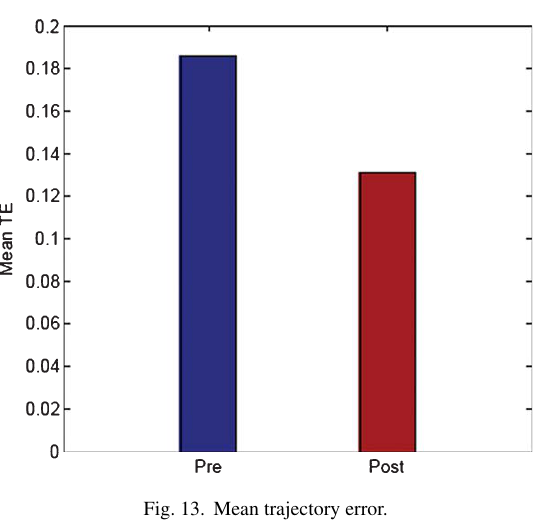
Fig. 13. Mean trajectory